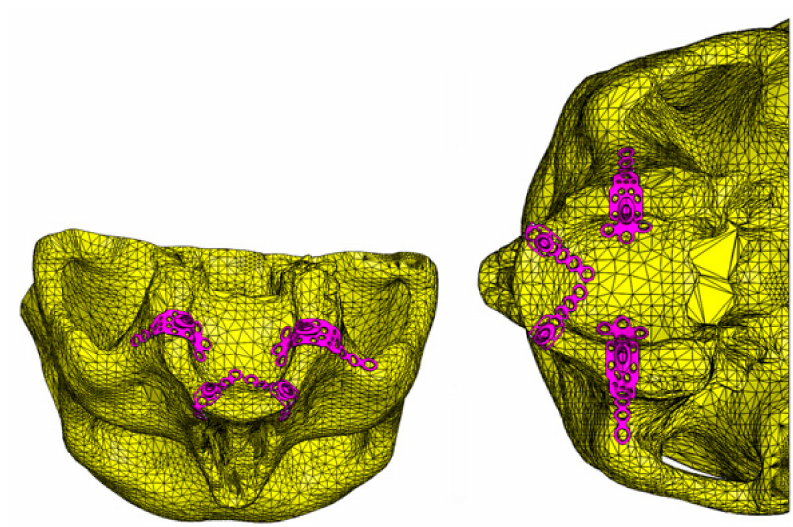
Figure 5. Model employed to reproduce in the finite element model.